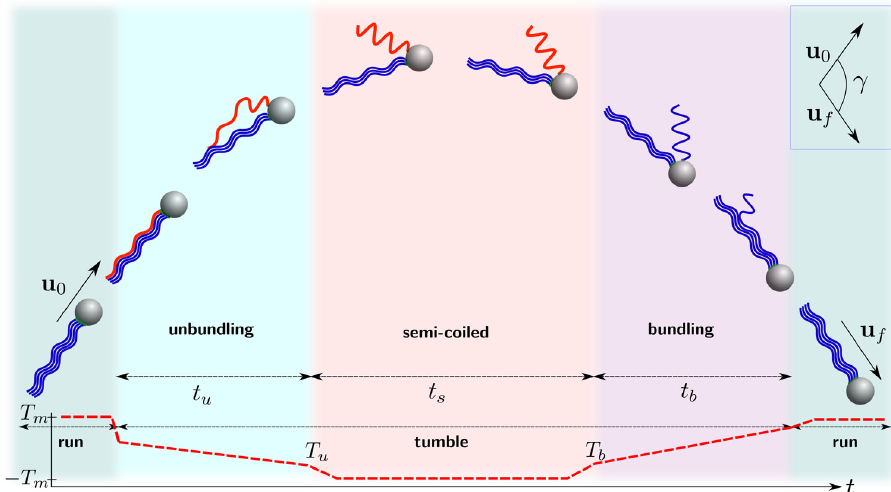
Fig 3. Schematic representation of the run-and-tumble dynamics of a peritrichous bacterium such as E. coli with four flagella along different stages of tumble. The red semi-coiled flagellum has a CW-rotating motor (when viewed from the distal cell body) while the blue normal ones rotate in the CCW direction. Bottom panel: Value of the motor torque for the filament undergoing the polymorphic transformation: (i) during runs, the torque is equal to a prescribed value T m ; (ii) when a tumble starts, the torque is gradually reduced, until it reaches the opposite value − T m when the flagellum has transformed to semi-coiled form; (iii) after bundling, the torque returns to the original value T definition of the change of direction angle, γ . Figure adapted from a similar sketch in Refs. [9] and